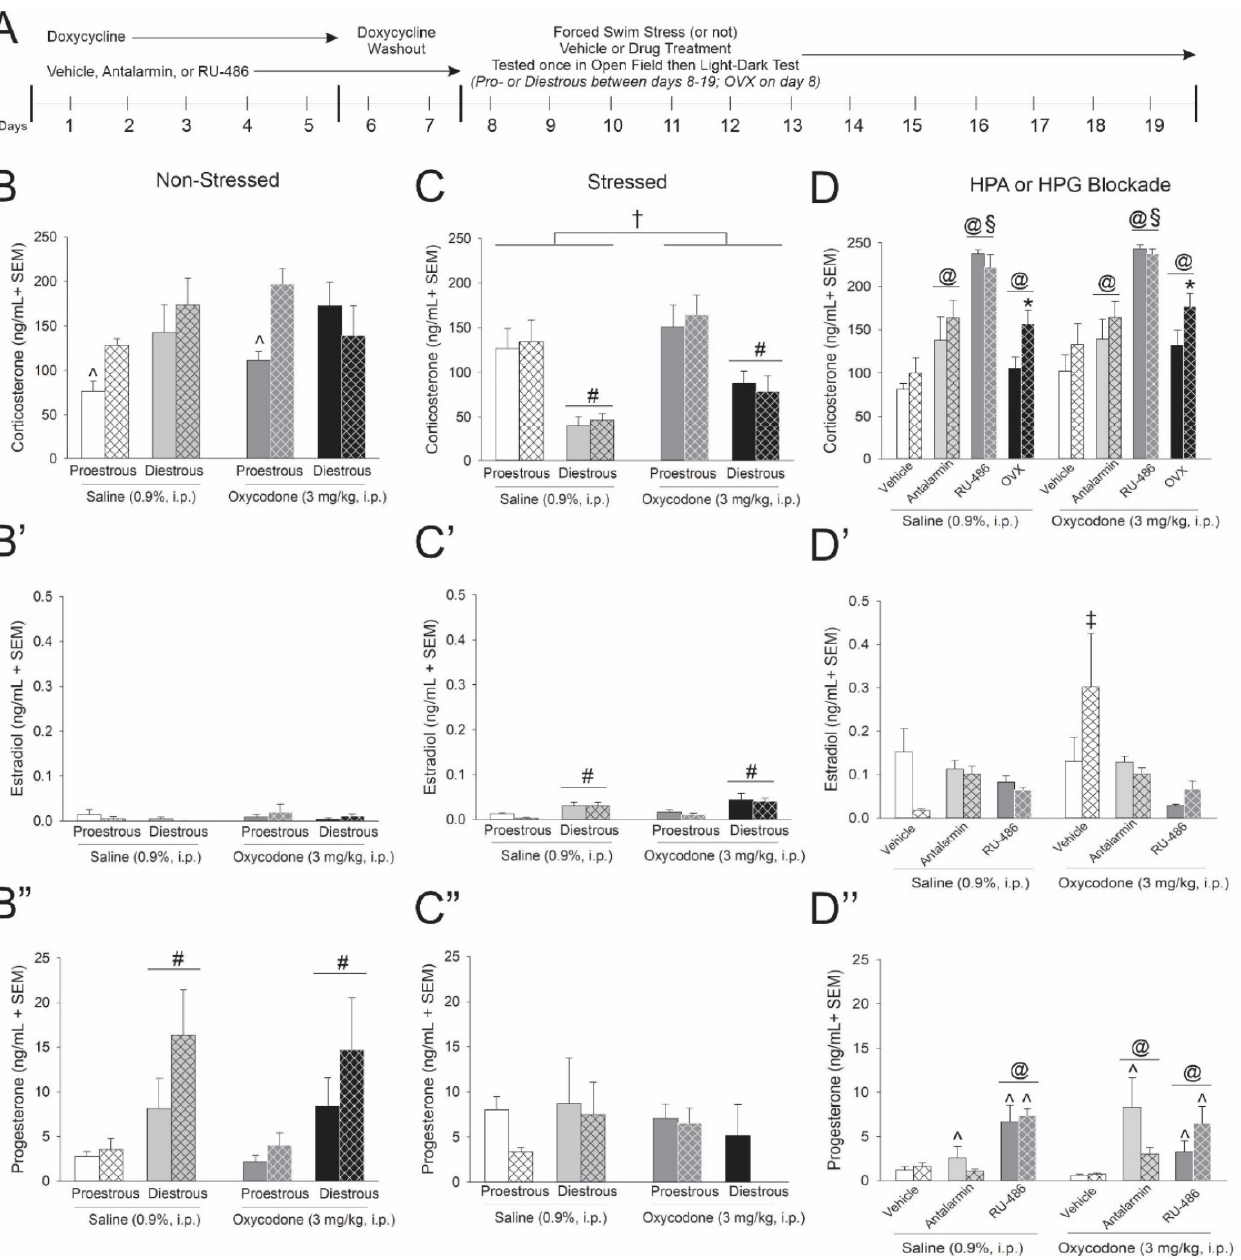
Figure 2. ( A ) Circulating steroid concentrations obtained from Tat-transgenic, female mice [hatched bars; Tat(+)] or control counterparts [open bars; Tat(−) controls] described in Figure 1 ( n = 6–10/group). Corticosterone, estradiol and progesterone were assessed in ( B – B’’ ) non-stressed, ( C – C’’ ) stressed and ( D – D’’ ) HPA or HPG manipulated mice. ^ indicates an interaction wherein the denoted group differs from all other groups in panelsB and D”. † indicates a main effect for oxycodone to differ from saline administered mice in panel C. § indicates an interaction wherein mice pretreated with RU-486 differ from all other groups in panel D. @ indicates an interaction wherein the denoted group differs from their respective vehicle controls in panel D and D”. * indicates a main effect of genotype wherein Tat(+) mice differ from Tat(−) controls in panel D. # indicates a main effect for proestrous mice to differ from diestrous mice in panel C, C’ and B”. ‡ indicates an interaction wherein the denoted group differs from all other groups in panel D’, p < 0.05.